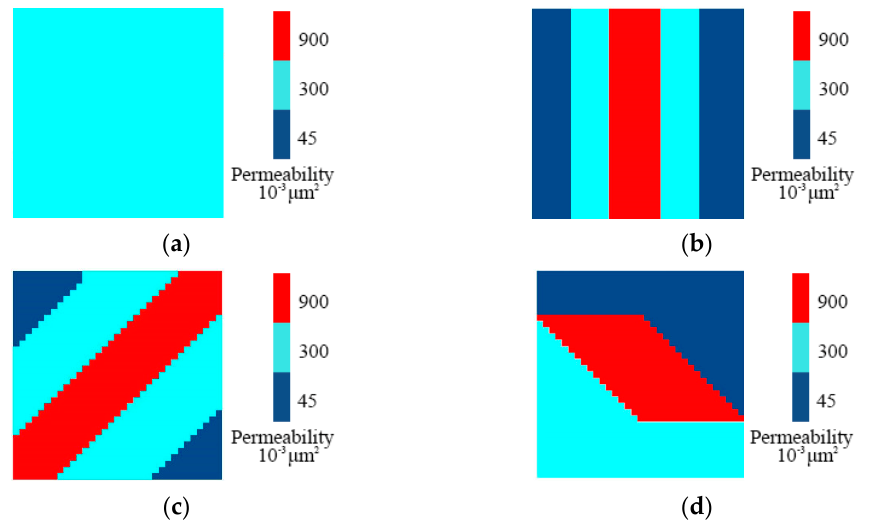
Figure 10. Permeability distribution of four single-layer synthetic models. ( a ) Homogeneous distri- bution; ( b ) vertical distribution; ( c ) diagonal distribution; ( d ) block-like distribution.